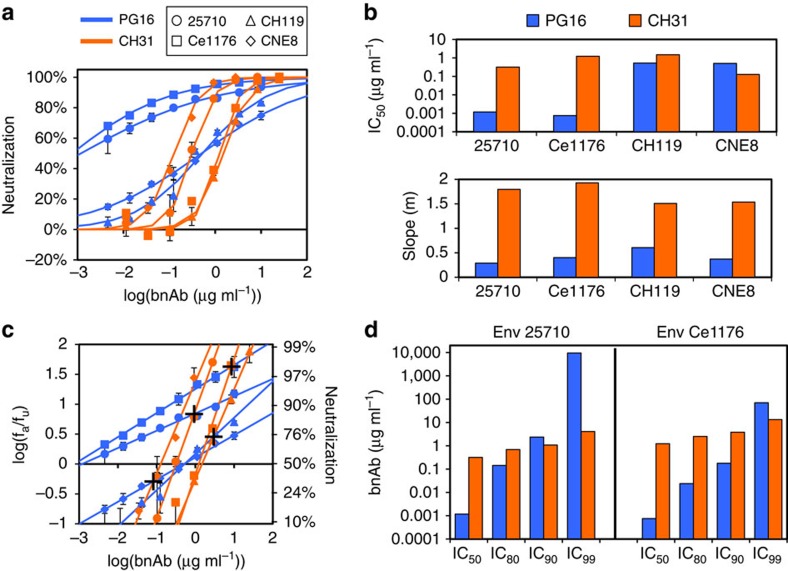
Effect of the slope on neutralization and potency.(a) Hill plots of neutralization curves for PG16 (blue) and CH31 (orange) against four representative Envs from our panel. (b) IC50 (top) and slope (bottom) values determined by median-effect fitting (Methods). (c) Linear median-effect plots of neutralization for the same data in a, where IC50 falls at the x intercept and slope describes the angle of each curve relative to the x axis. Intersections (crosses) indicate where both PG16 and CH31 gave the same neutralization at the same concentration for each Env. (d) Potencies of PG16 and CH31 against two Envs with the greatest difference in IC50. Data shown in (a) and (c) are the average of two replicates and error bars indicate s.d.